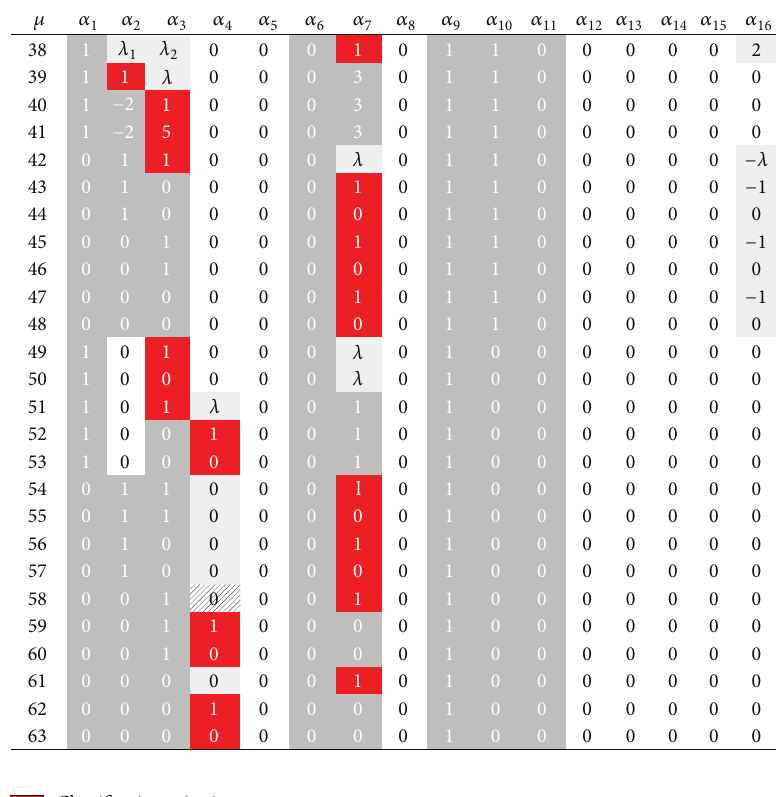
Figure 4: Case B.1.2: 𝛼 11 = 0 ; 𝛼 9 ̸=0 , and 𝛼 6 = 0 ; classification of the QFLA of dimension